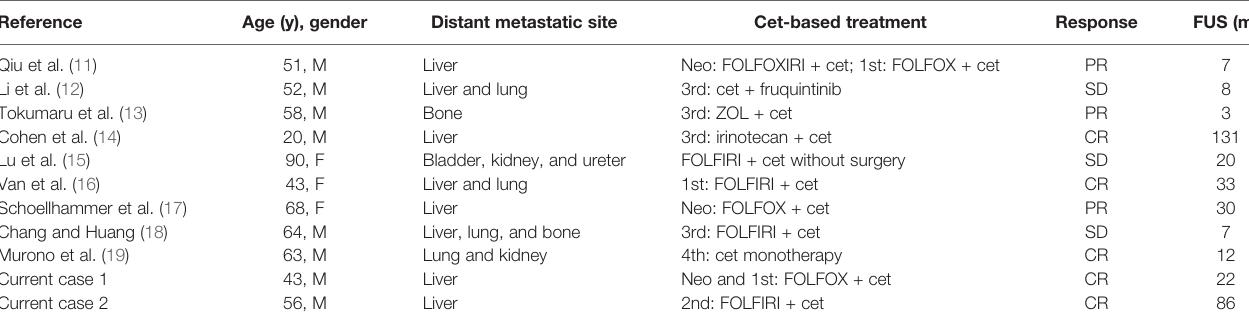
TABLE 2 | Metastatic colorectal cancer cases bene fi tted from cetuximab-based treatment.